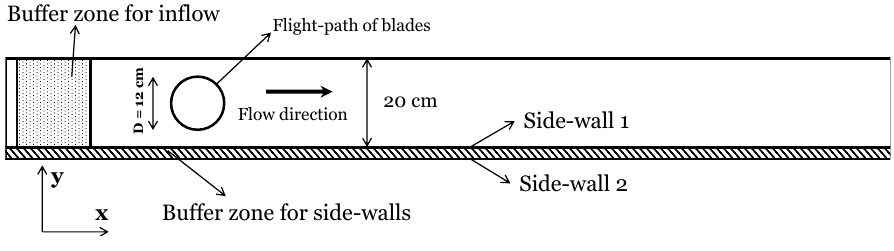
Figure 7. x-y view (normal to the blades) of the computational